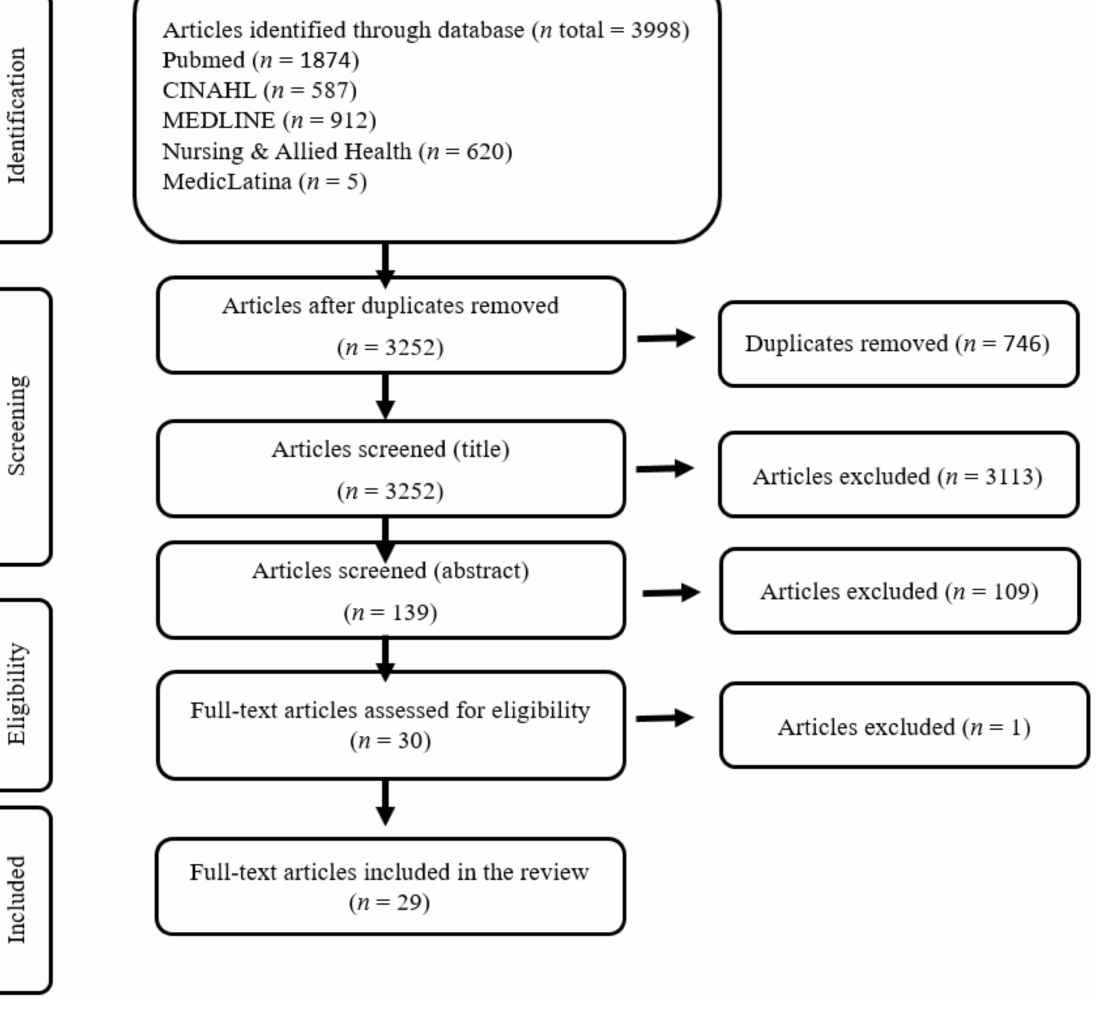
Figure 1. PRISMA flow